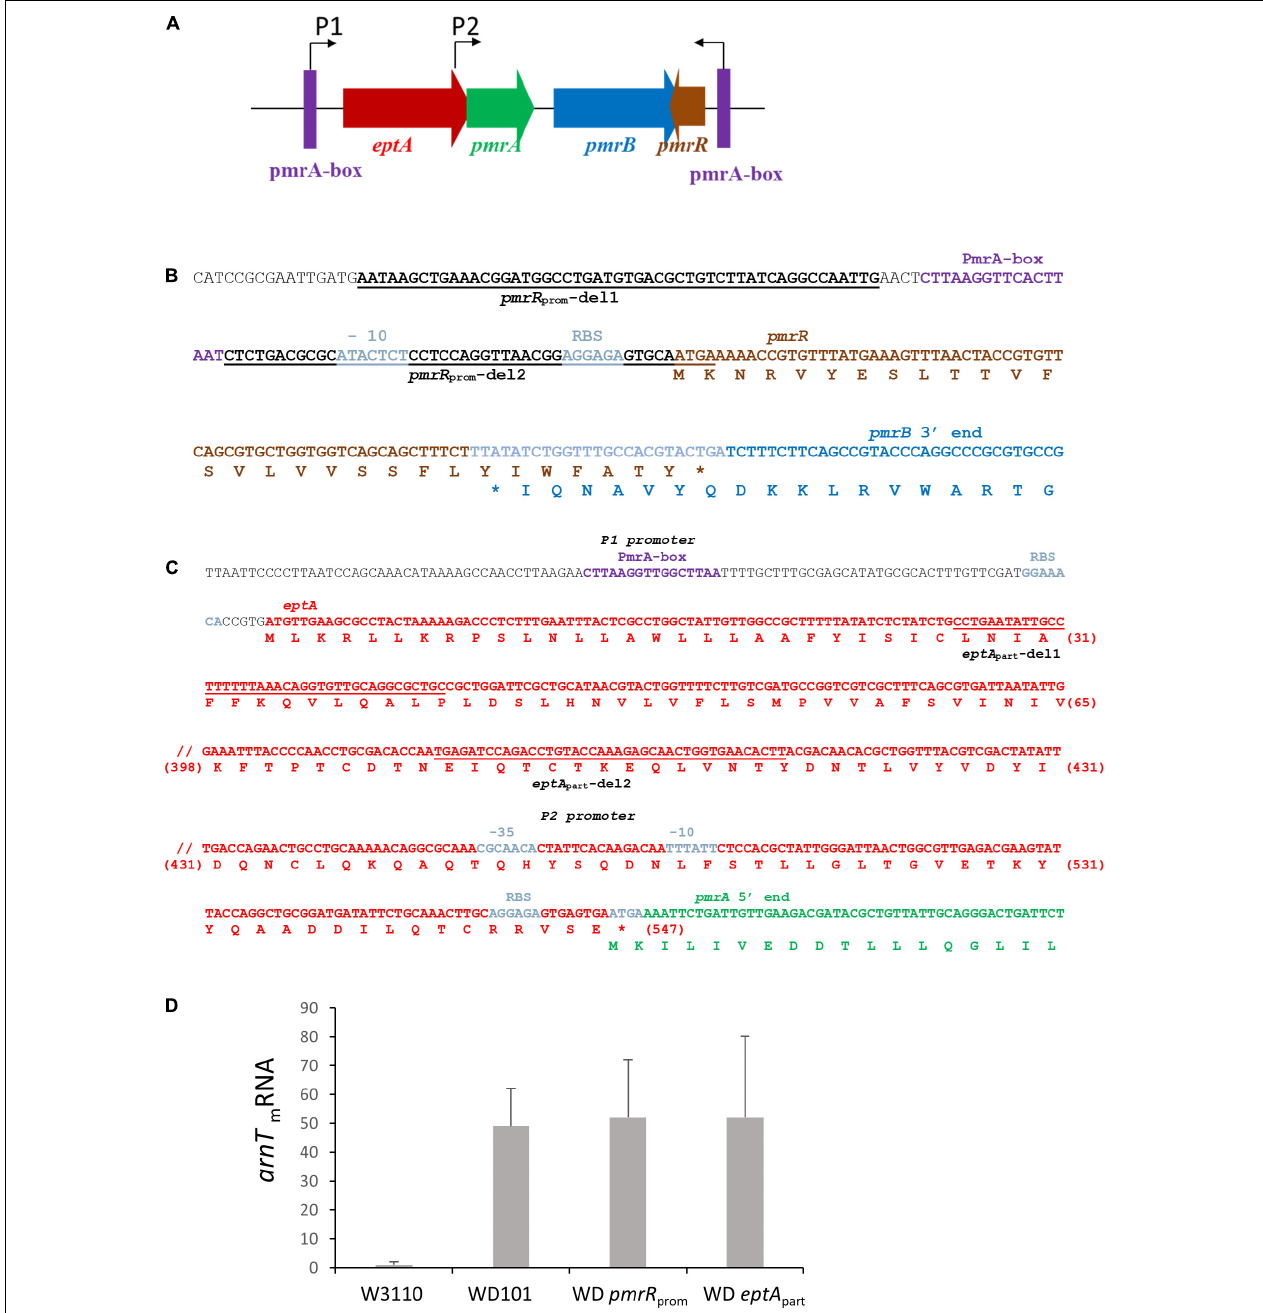
FIGURE 7 | Construction of deletion mutants within the eptA - pmrAB-pmrR locus. (A) Schematic representation of the eptA - pmrAB operon and the divergently transcribed and overlapping pmrR gene. The expression of eptA-pmrAB operon is controlled by a PmrA-dependent promoter P1 (PmrA-box) and an internal promoter P2, while the expression of pmrR is controlled by a PmrA-dependent promoter (PmrA-box). The WD pmrR prom and WD eptA part deletion strains were generated by the Datsenko and Wanner method (Datsenko and Wanner, 2000). (B) DNA sequence of pmrR gene and the overlapping 3 (cid:48) -end sequence of pmrB . The regions of hybridization of primers pmrR prom -del1 and pmrR prom -del2 used for the deletion are underlined. The amino acid sequences are indicated below the DNA sequence. (C) DNA sequence of eptA gene and the overlapping 5 (cid:48) -end sequence of pmrA . The regions of hybridization of primers eptA part -del1 and eptA part -del2 used for the deletion are underlined. The amino acid sequences are indicated below the DNA sequence and the amino acid position within EptA sequence is indicated between brackets. (D) Q-PCR analysis of the transcriptional level of arnT gene in W3110, WD101, WD eptA part , and WD pmrR prom strains. Total RNAs were extracted from bacterial cells grown in 2YT medium up to OD 600 nm = 0.5 and they were used for cDNA synthesis. The level of arnT mRNA was quantified by Q-PCR and normalized using housekeeping genes. Data correspond to the mean of three independent experiments.